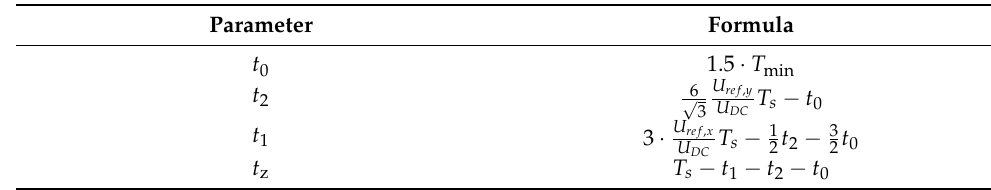
Figure 9. ( a ) Vector limitation using the proposed modified SVM pattern for the central part of an unreachable area; ( b ) proposed modified SVM pattern used for the central part of an unreachable area; ( c ) proposed modified SVM pattern used for an unreachable area close to Region 3; ( d ) proposed modified SVM pattern used for an unreachable area close to Region 4. Table 6. Time calculation for the proposed SVM pattern for Region 2 applied inside the inner